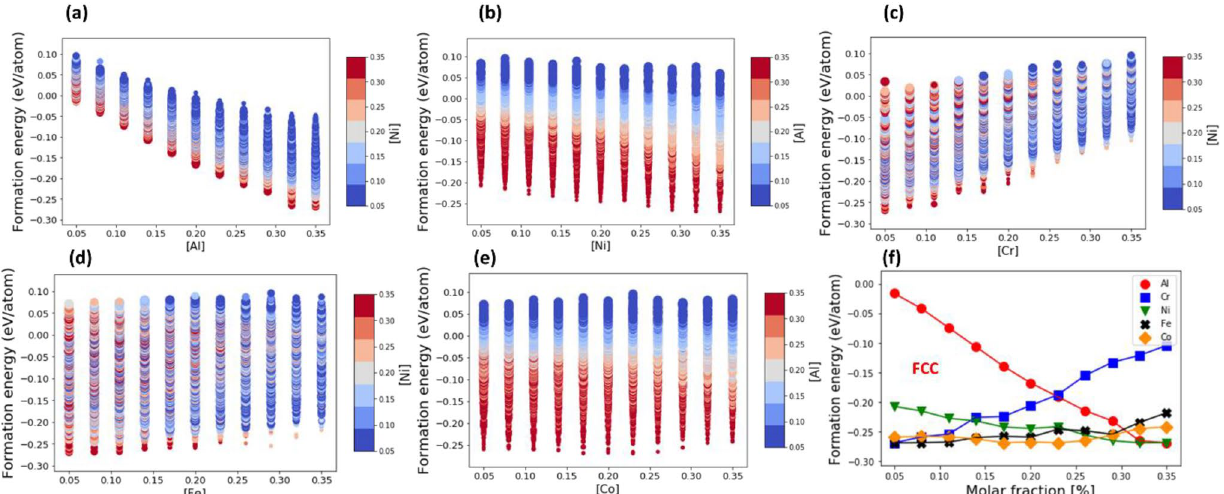
Figure 3. The effect of molar fraction of constituent elements on the formation energy of FCC AlCoCrFeNi. The formation energy of the AlCoCrFeNi HEA is plotted vs. molar fraction of Al ( a ), Ni ( b ), Cr ( c ), Fe ( d ) and Co ( e ). For a given HEA composition, marker color indicates the molar fraction of Ni in ( a ), ( f ), ( d ) and Al in ( b ), ( e ). Marker size corresponds to the molar fraction of Co in ( a ), ( f ), ( d ) and Cr in ( b ), ( e ). ( f ) The formation energy minimum of the AlCoCrFeNi HEA with an FCC lattice as a function of molar fraction of constituent elements: Al (red circles), Cr (blue squares), Ni (green triangles), Fe (black crosses) and Co (orange diamonds).